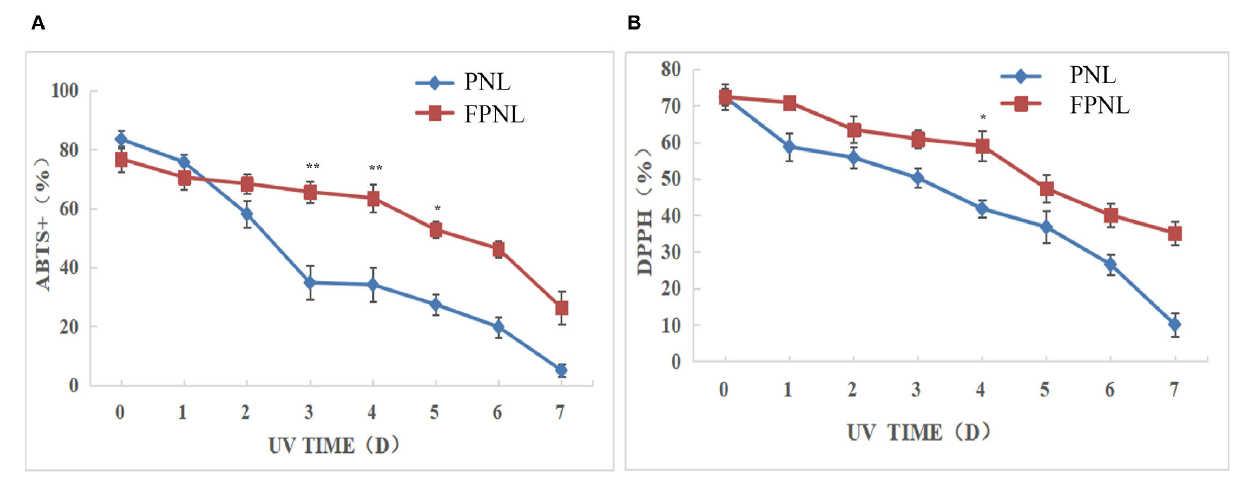
FIGURE 2 | Changes of ABTS and DPPH free radical scavenging rates of PNL and FPNL. (A) Changes in ABTS rates of PNL and FPNL. (B) Changes in DPPH rates of PNL and FPNL. * P < 0.05, ** P < 0.01 vs. PNL group.